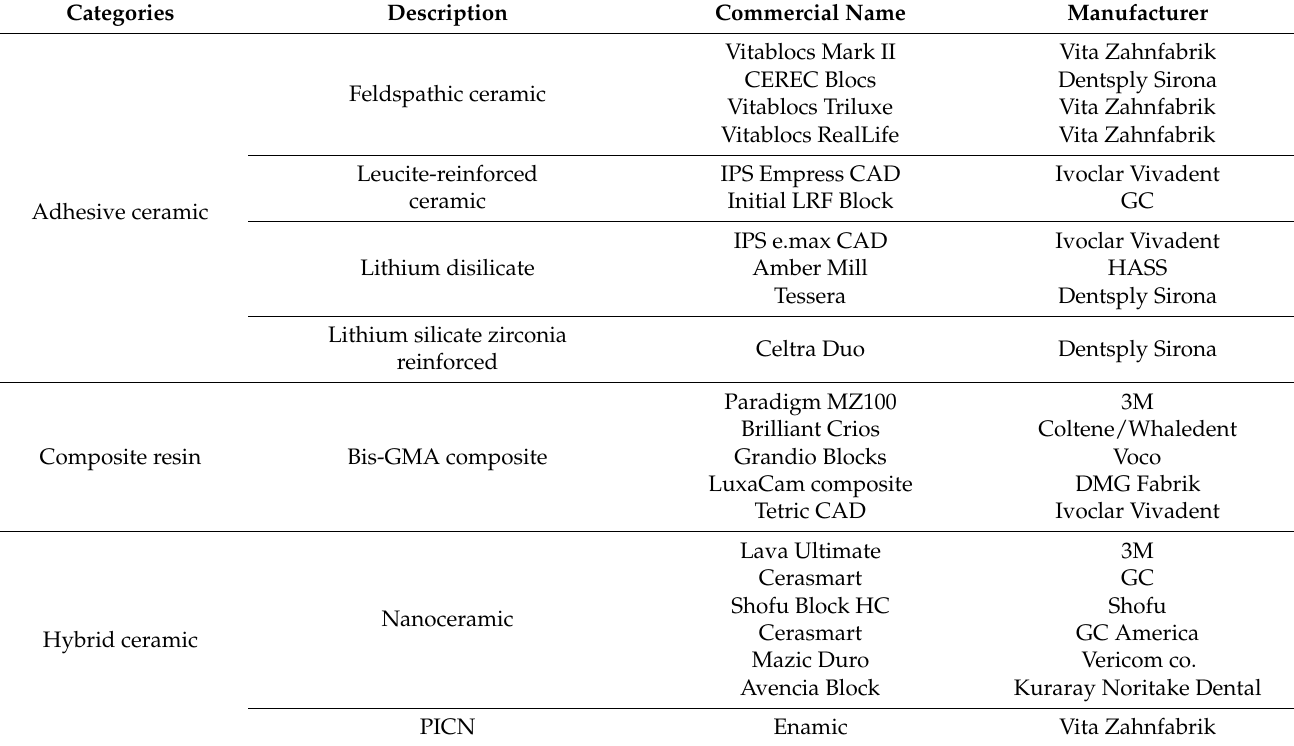
Table 1. Summary of the products presented in the